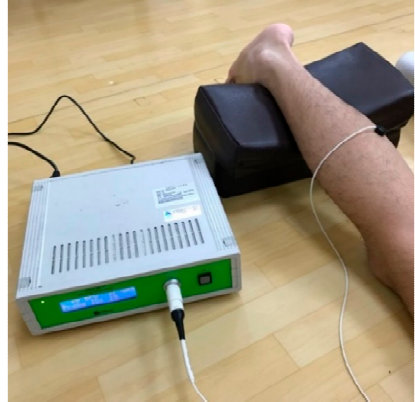
Figure 4. The skin blood flow measurement.